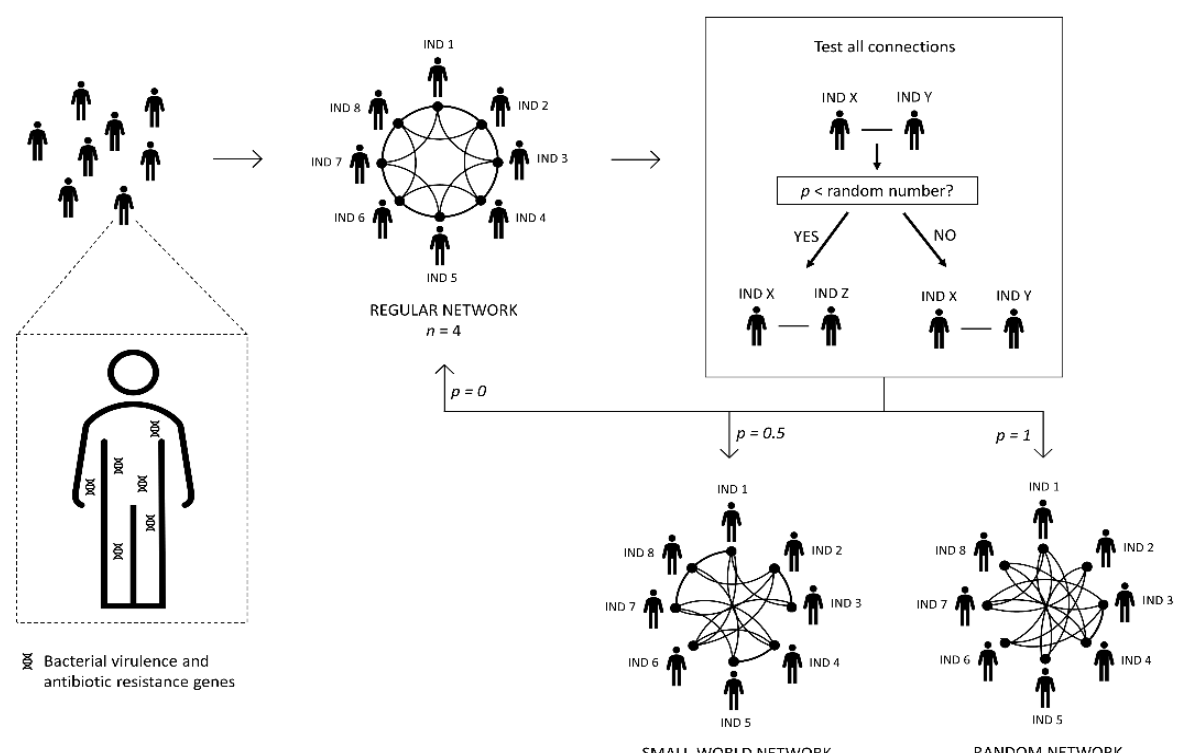
Figure 1. Each human being in a community is colonized by bacteria (as an integral part of the microbiome). Some bacteria contain antibiotic resistance genes and/or virulence genes. These bacteria can be transmitted from one person to another, which includes the passage of resistance and/or virulence genes that they may contain. All the individuals in the community are organized in a network of contacts. In the regular network, each individual is linked to other four individuals (the four closest individuals; n = 4). The other two types of network were constructed following Watts and Strogatz method [37]. From the regular network, each connection has a probability p to change, that is, each individual can be reconnected to another one in the network. Therefore, the value of p defines the type of network: (i) p = 0 the network remains regular; (ii) p = 0.5 is a small-world network; (iii) p = 1 the network becomes random.